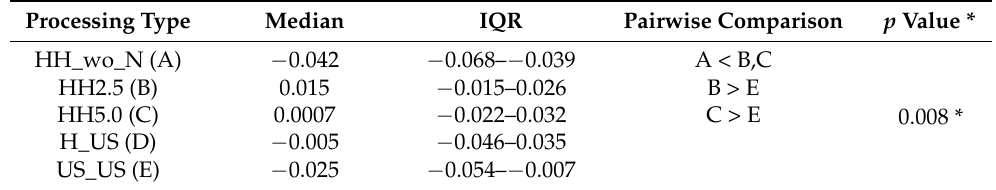
Table 4. Results from Kruskal–Wallis test for pairwise comparisons using median (trueness) and in- terquartile range (IQR) (precision) for various processing types. All measurements are in